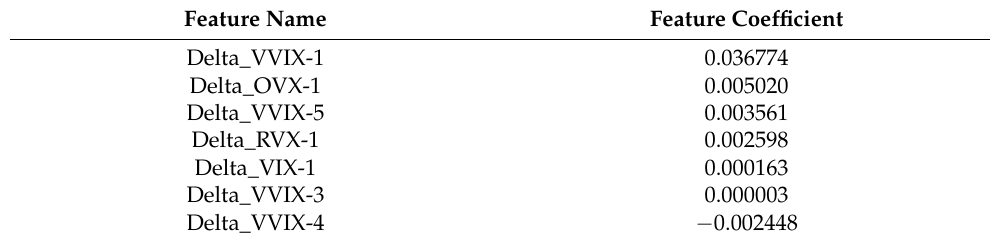
Table 8. Feature coefficients generated from logistic regression.